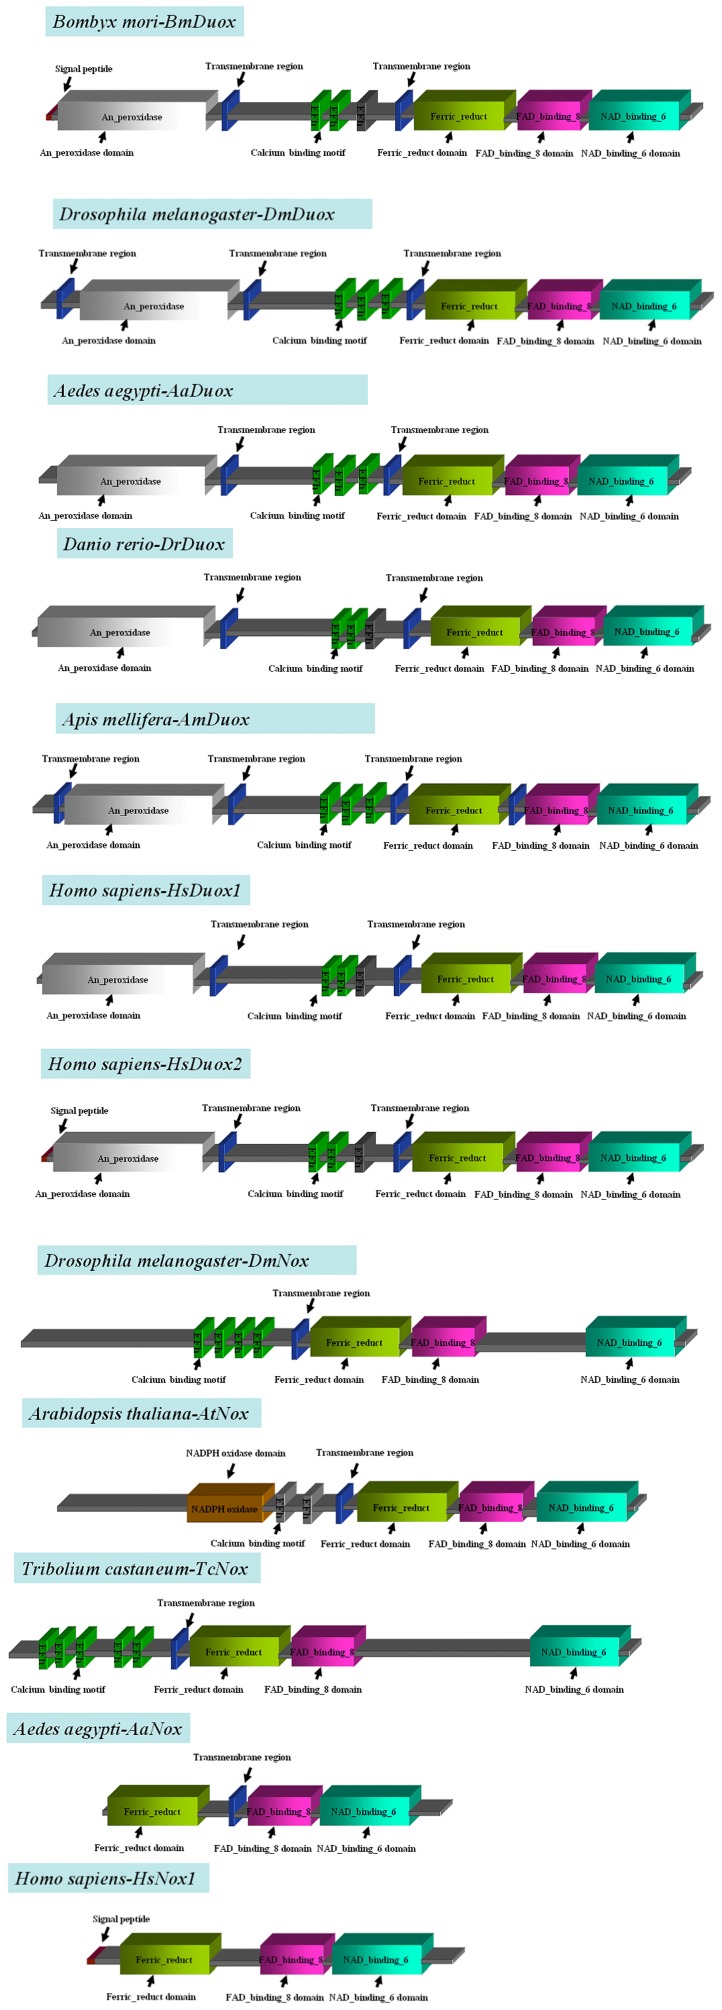
Domain organizations of Duox/Nox proteins.The calcium-binding region contains EF-hand motifs in BmDuox. The ORFs from BmDuox and Duox/Nox of other species are compared: Bombyx mori Duox, BmDuox (JQ768349); Drosophila melanogaster Duox, DmDuox (NP_608715.2); Aedes aegypti Duox, AaDuox1 (XP_001658452.1); Danio rerio Duox, DrDuox (BAF33370.1); Homo sapiens Duox2, HsDuox2 (NP_054799.4); Homo sapiens Duox1, HsDuox1 (NP_059130.2); Drosophila melanogaster Nox, DmNox (NP_001097336); Arabidopsis thaliana Nox, AtNox (O81211.2); Tribolium castaneum Nox, TcNox (XP_972375.2); Aedes aegypti Nox, AaNox (EAT37894); Homo sapiens Nox1, HsNox1 (CAI42337.1).